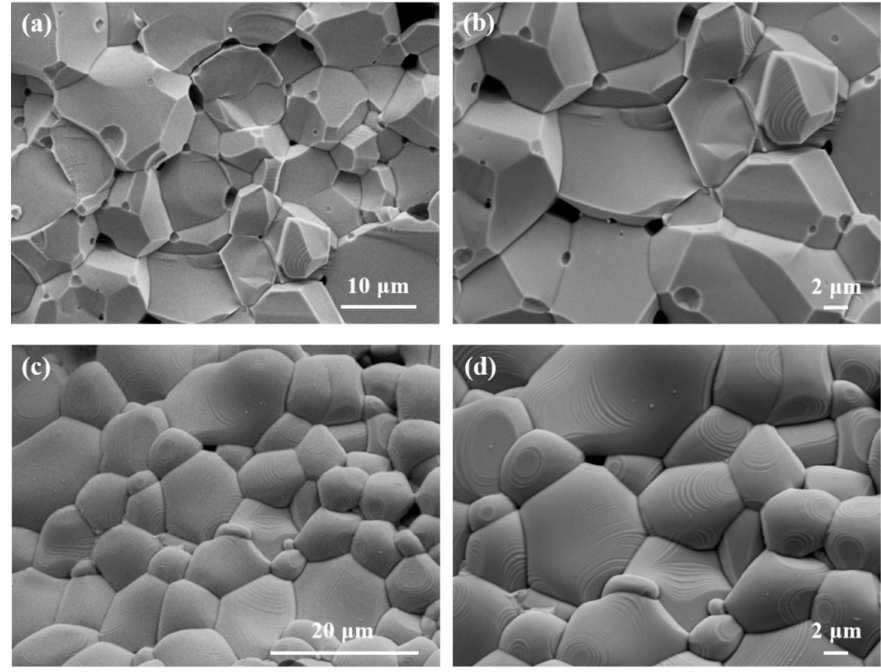
Figure 2. SEM images of typical MnZn ferrite samples. ( a , b ) 0 wt% ordinary MnZn ferrite; ( c , d ) 2 wt% homogeneous-fiber-reinforced MnZn